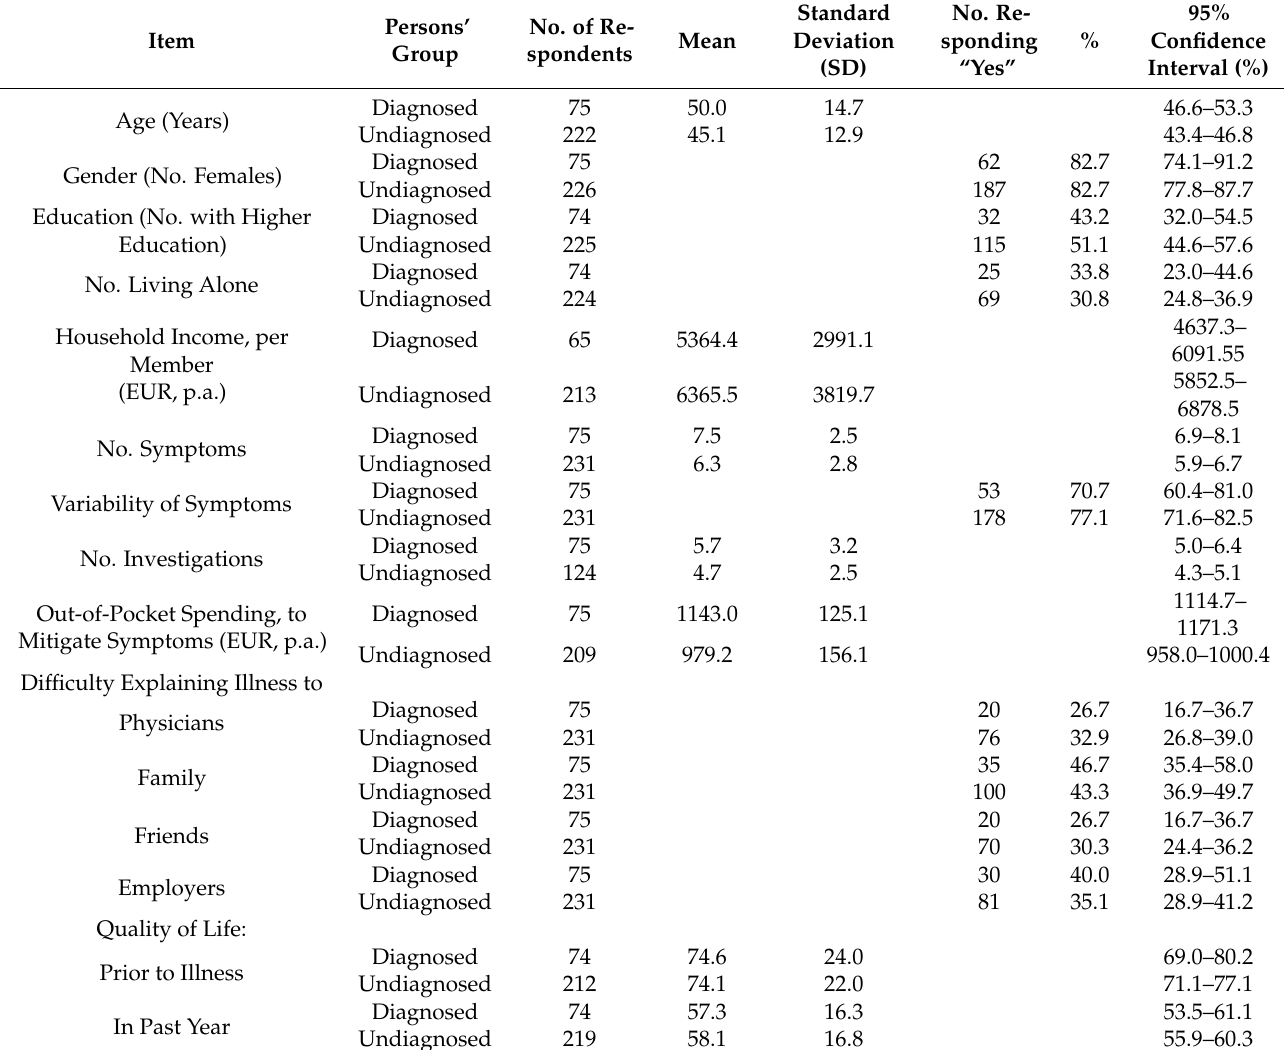
Table 2. Main results of the survey of ME/CFS patients and undiagnosed